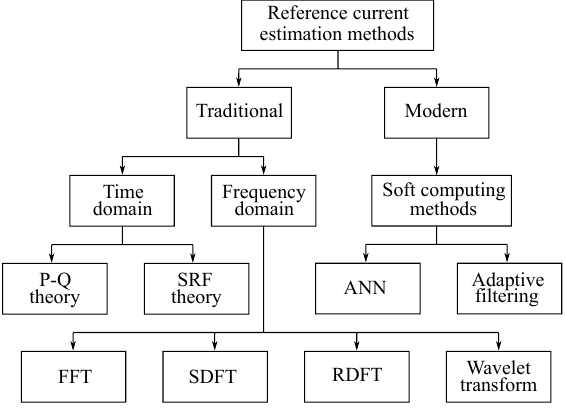
Figure 16. Schematic diagram of current estimation